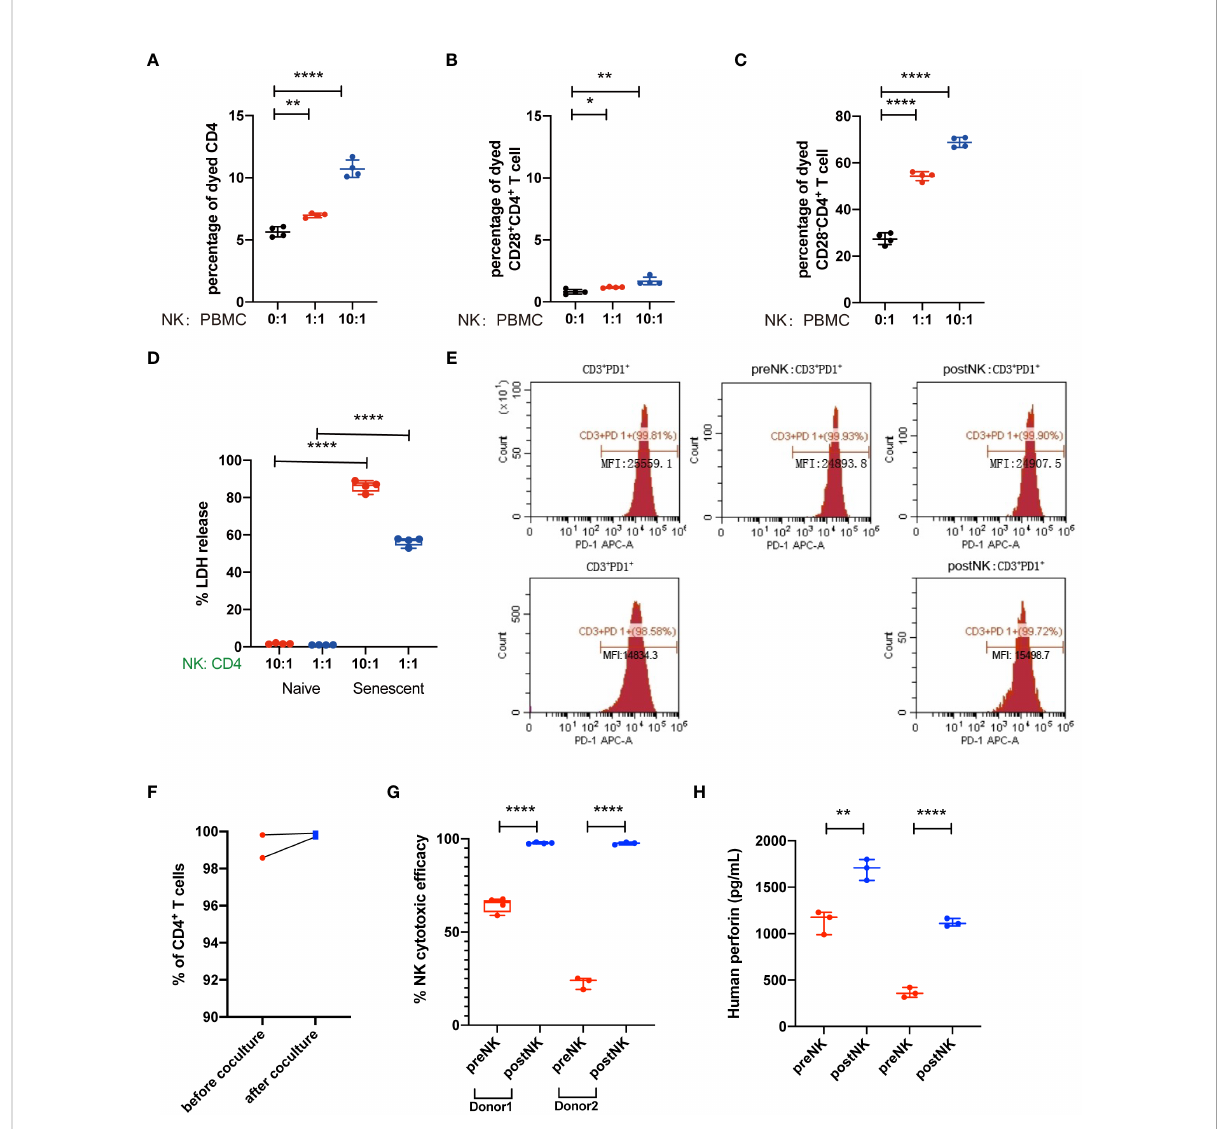
FIGURE 7 NK cells kill senescent CD4 + T cells but not normal CD4 + T cells. (A) Representative fi gure showed the percentages of dead CD4 + T cells. (B) Percentages of dead CD4 + T cells as indicated in (A) . (C) Representative fi gure showed the percentages of dead CD28 + CD4 + T cells. (D) Percentages of dead CD28 + CD4 + T cells as indicated in (C) . (E) Representative fi gure showed the percentages of dead CD28 - CD4 + T cells. (F) Percentages of dead CD28 - CD4 + T cells as indicated in (E) . (G) CD28 + CD4 + T cells and CD28 - CD57 + CD4 + T cells were sorted from